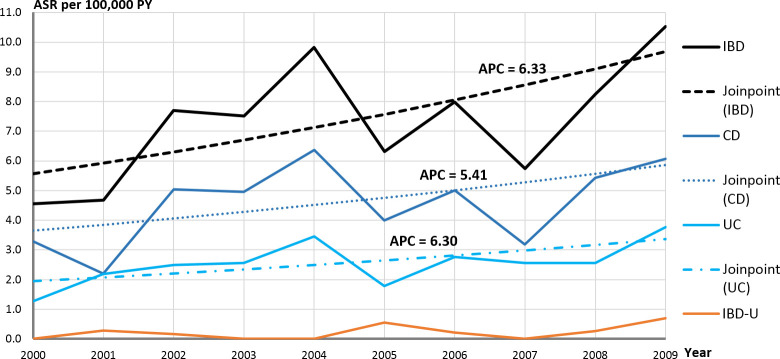
Incidence trends of age-standardized incidence rates (ASR per 100,000 PY) in Saxony, Germany by joinpoint regression with corresponding equations by all Inflammatory Bowel Disease (IBD) and separated by single diseases.Crohn’s disease (CD), ulcerative colitis (UC) and unclassified IBD (IBD-U).